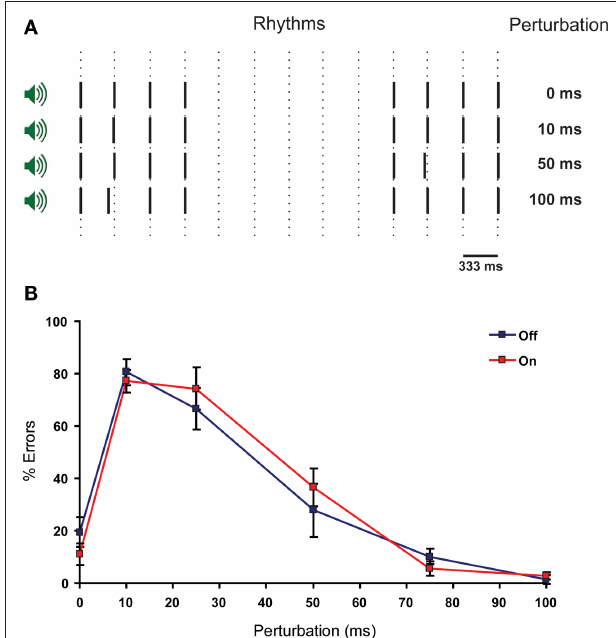
Figure 2 | Perception of complex rhythms is not impaired by the intake of mefloquine. (A) Schematic representation of the rhythm perception task. Two rhythms consisting of four tones are separated by a pause of 2 s. One of the rhythms has a timing perturbation of the second tone. This perturbation varies in size (0, 10, 25, 50, and 100 ms). The subject has to determine whether the rhythms are identical or different. (B) The ability to distinguish complex rhythmic stimuli as a function of perturbation length (ms) is reflected in the number of errors made per type of perturbation. Blue squares indicate mean % of errors ± SEM (error bars) before mefloquine intake and red squares indicate mean % of errors ± SEM (error bars) 24 h after mefloquine intake ( n = 9).